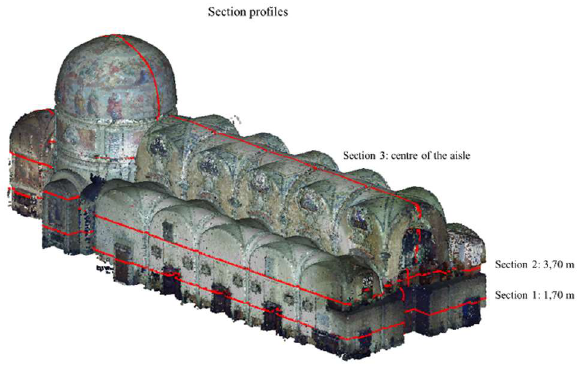
Figure 11. Slices extracted from the reference point cloud.